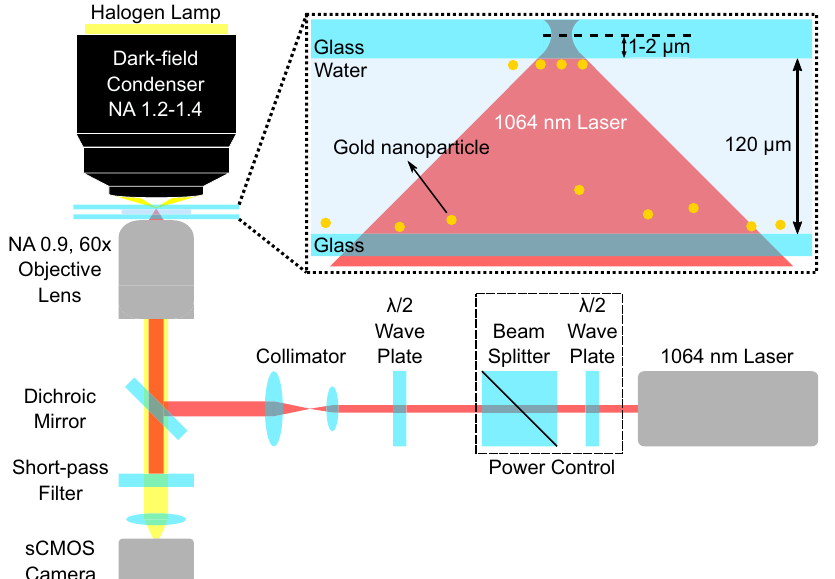
Fig. 1 | Experimental setup for optical trapping of Au NPs at the upper glass/solution interface. The upper dashed-line inset shows the illustration of the sample conditions at the trapping spot.